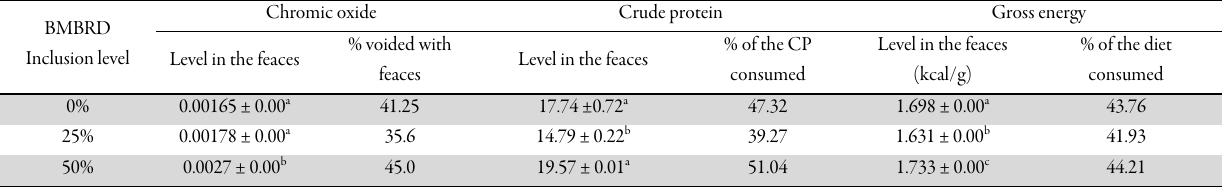
*Means within column with different superscripts are significantly different